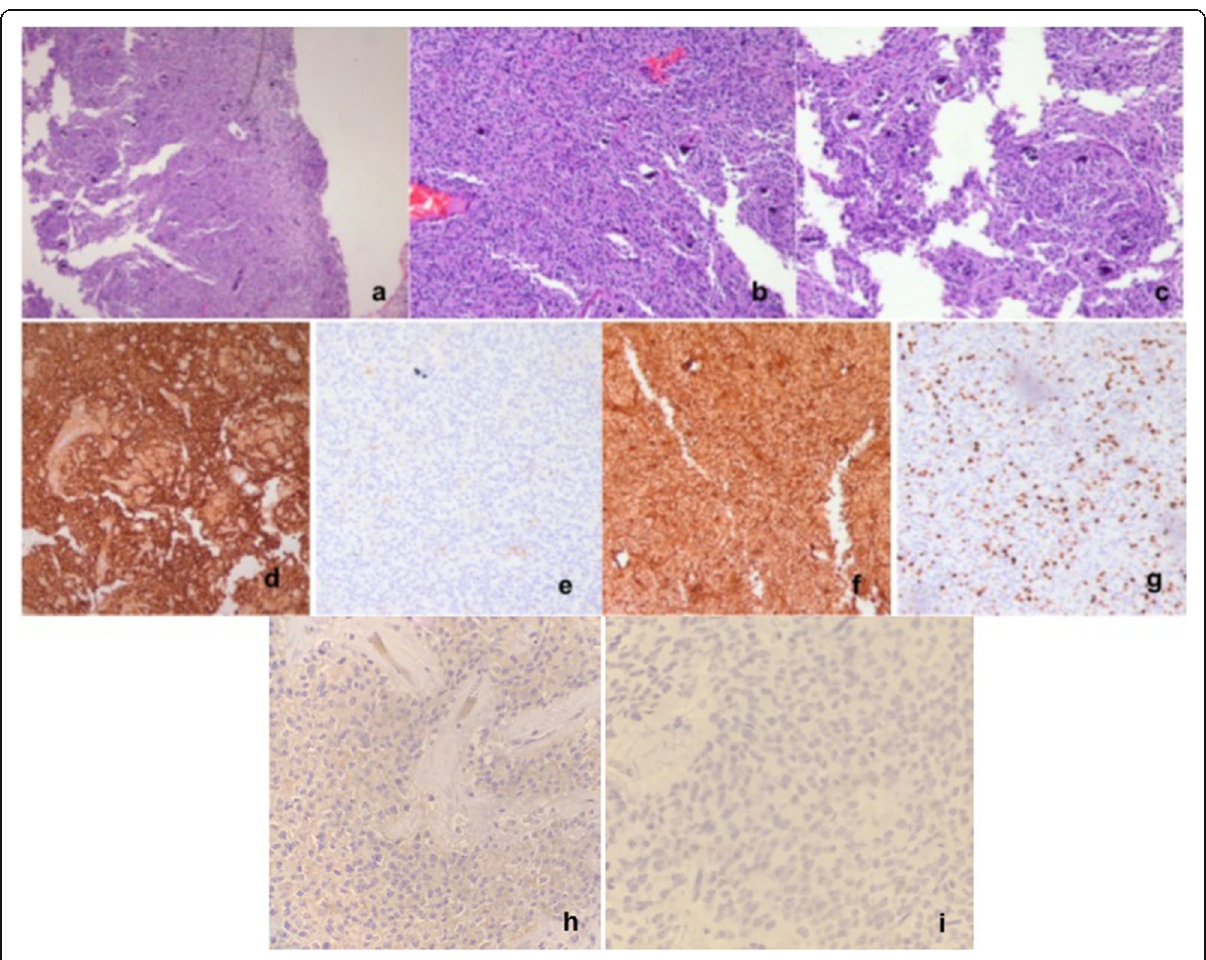
Fig. 2 a Photomicrographs showing sections of tumor tissue composed of sheets of oligodendrogioma-like cells with round to oval nuclei within a clear cytoplasm in a delicate vascular network, intervening neutrophils, calcification, and Homer-Wright Rosettes (H&E, 4×). b , c High power views (H&E, 10×) showing necrosis, microvascular proliferation, several mitoses, and areas of hemorrhage. d Immunostaining showing diffuse positivity for synaptophysin. e Tumor cells are immunonegative for epithelial membrane antigen (EMA). f Focal positivity seen for glial fibrillary acid protein (GFAP). g Ki-67 labeling index was 8 – 10%. h Isocitrate dehydrogenase 1 (IDH-1) and i chromogranin were negative on immunostaining. The morphological and immunohistochemical features are those of an atypical